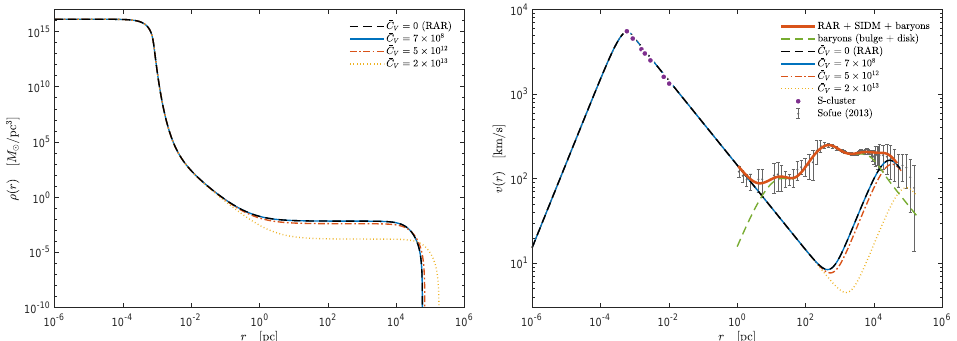
Figure 17. Density profiles ( left panel ) and rotation curves ( right panel ) of the extended RAR model with both self-interactions and escape of particle effects. Solutions are shown with four different self-interaction constant values ¯ C V , including the case of ¯ C V = 0 in black dashed lines, corresponding to the original Milky Way fit presented in [32]. The model fits the observed total rotation curve data from [45] (with error bars). The predicted rotation curve (in solid red) shows the excellent fit to the data for ¯ C V = 7 × 10 8 (in solid blue) and baryonic components (in green dashed lines). Notice that the DM halo becomes more extended and less dominant, implying an underfit to the data for large enough ¯ C V > 10 13 , due to the additional pressure term contribution of the boson mediator field. Reprinted from [80], Copyright (2020), with permission from